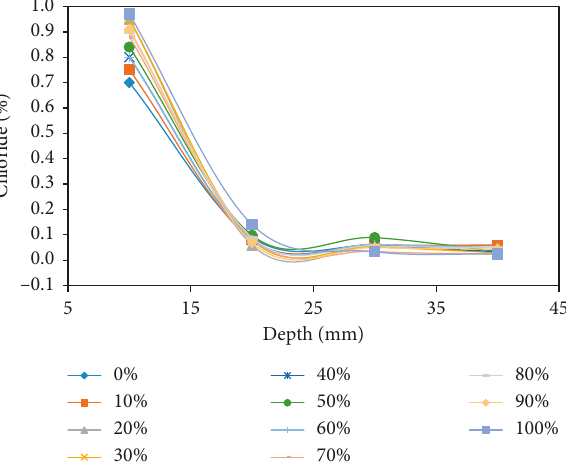
Figure 11: Chloride diffusion for all mixes after 4